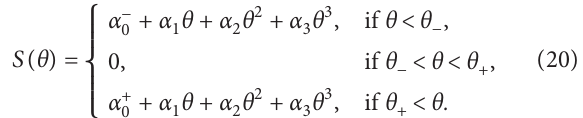
� α � 0. For α > 0, the neutral solution becomes unstable and two new stable solutions appear. 0 2 1 | , two stable solutions 0